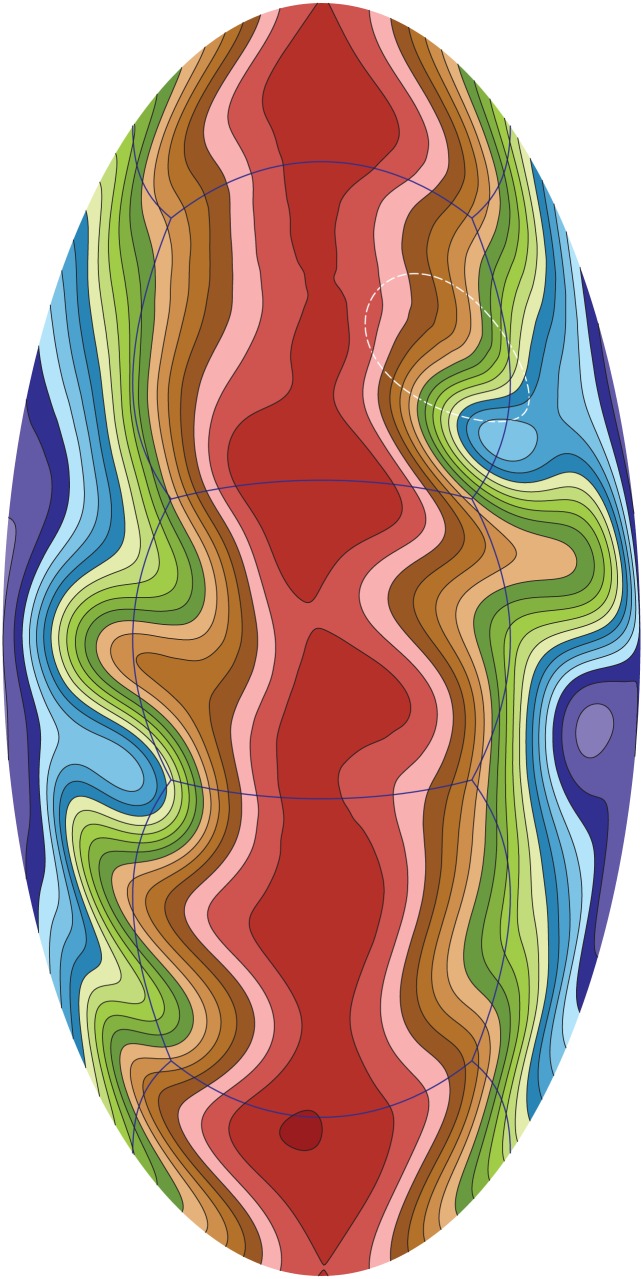
Surface level distribution of the atmosphere at day 15 on Tianhe-1A based on the model test [34].The conical mountain is outlined by the dotted circle.